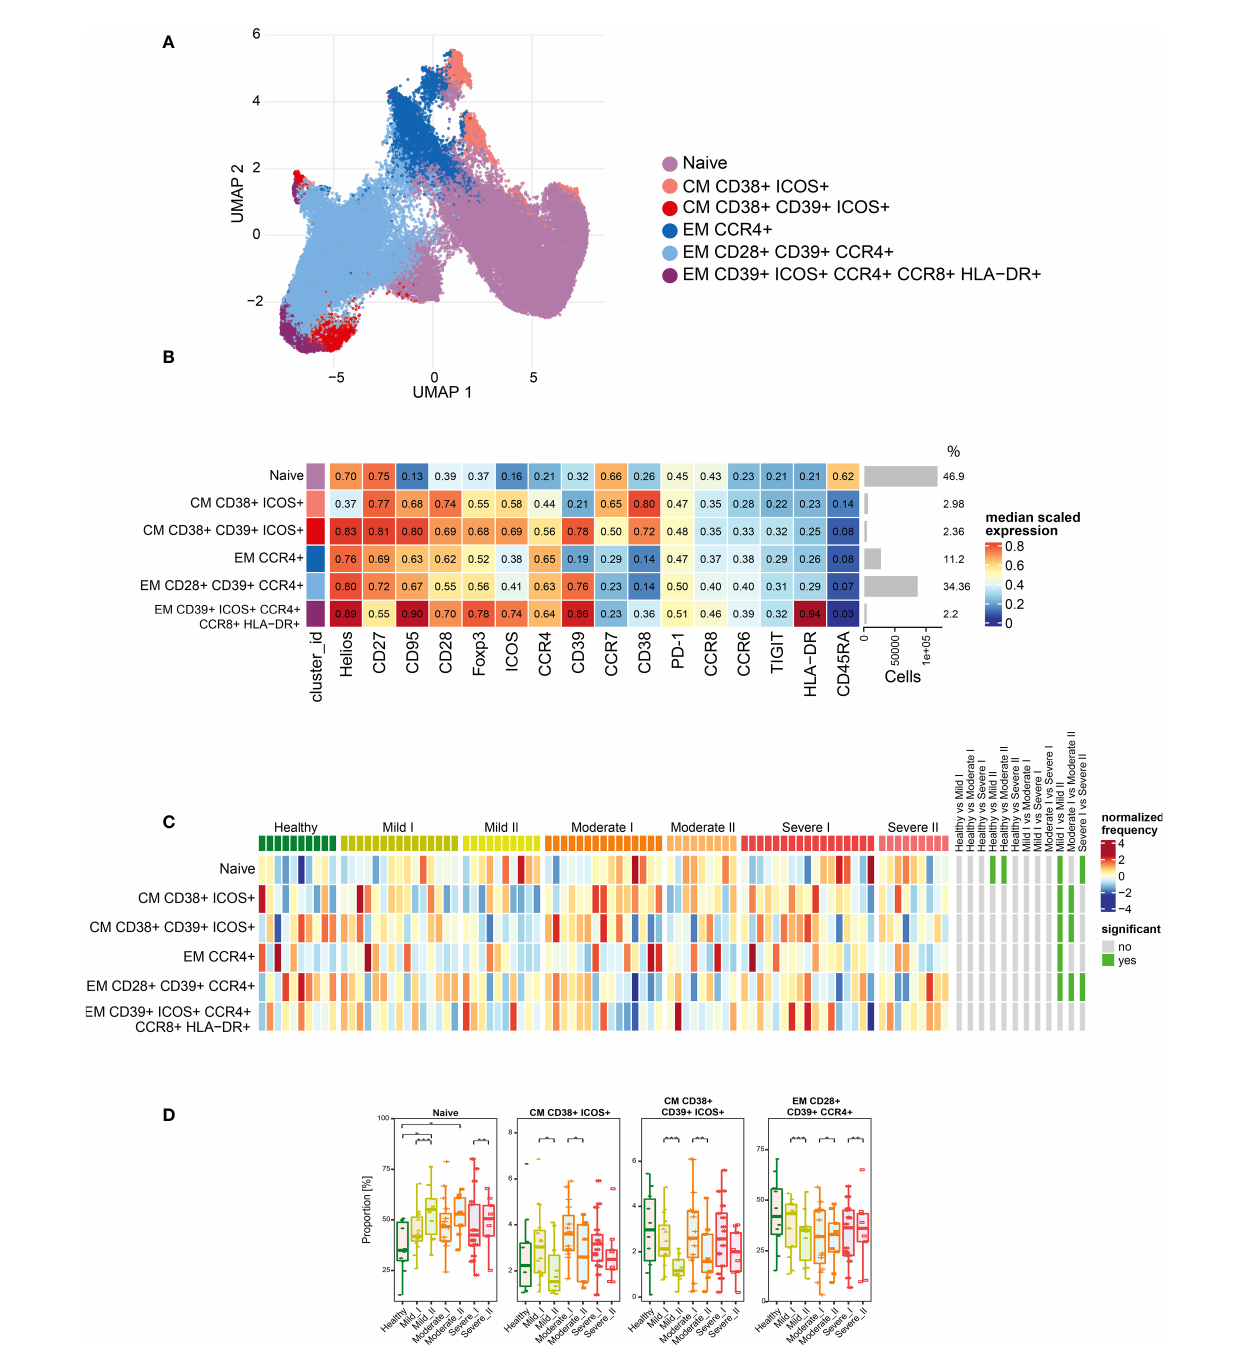
FIGURE 4 | Unsupervised analysis of Treg cells and their characterization. (A) Uniform Manifold Approximation and Projection (UMAP) UMAP representation of Treg cell landscape. (B) Heat map representing different clusters identi fi ed by FlowSOM, with relative identity and percentages in healthy controls and convalescent patients. The color in the heat map represents the median of the arcsinh, 0 – 1 transformed marker expression calculated over cells from all the samples, varying from blue for lower expression to red for higher expression. Each cluster has a unique color assigned (bar on the left). Barplots along the rows (clusters) and values on the right indicate the relative sizes of clusters. (C) Differential analysis of all severity groups of COVID-19 convalescent patients (mild, moderate, severe), as well as healthy donors at the time points I and II. The heat represents arcsine-square-root transformed cell frequencies that were subsequently normalized per cluster (rows) to mean zero and standard deviation of one. The color of the heat varies from dark blue indicating relative under-representation to red indicating relative over-representation. Bars at the right indicate signi fi cantly differentially abundant clusters (green). (D) Differential proportion of selected clusters presented as % of Treg cells. *p ≤ 0,05; **p ≤ 0,01; ***p ≤